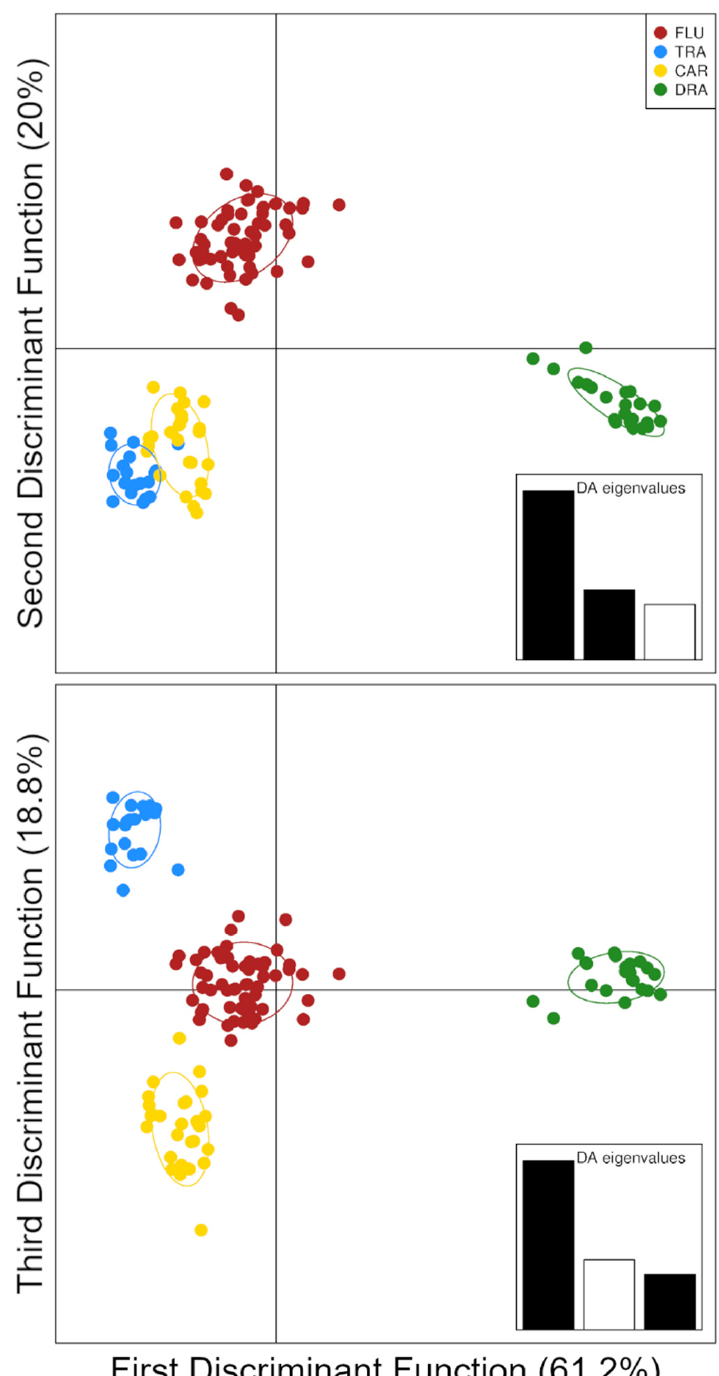
Figure 3. Genetic structure inferred from Discriminant Analysis of Principal Components (DAPC). Each dot represents an individual fish and is coloured according to the sampling locality as well as the 95% inertia ellipses. Black bars in each inset show which discriminant functions are plotted. Bar height is proportional to the amount of genetic variation explained by each DF.